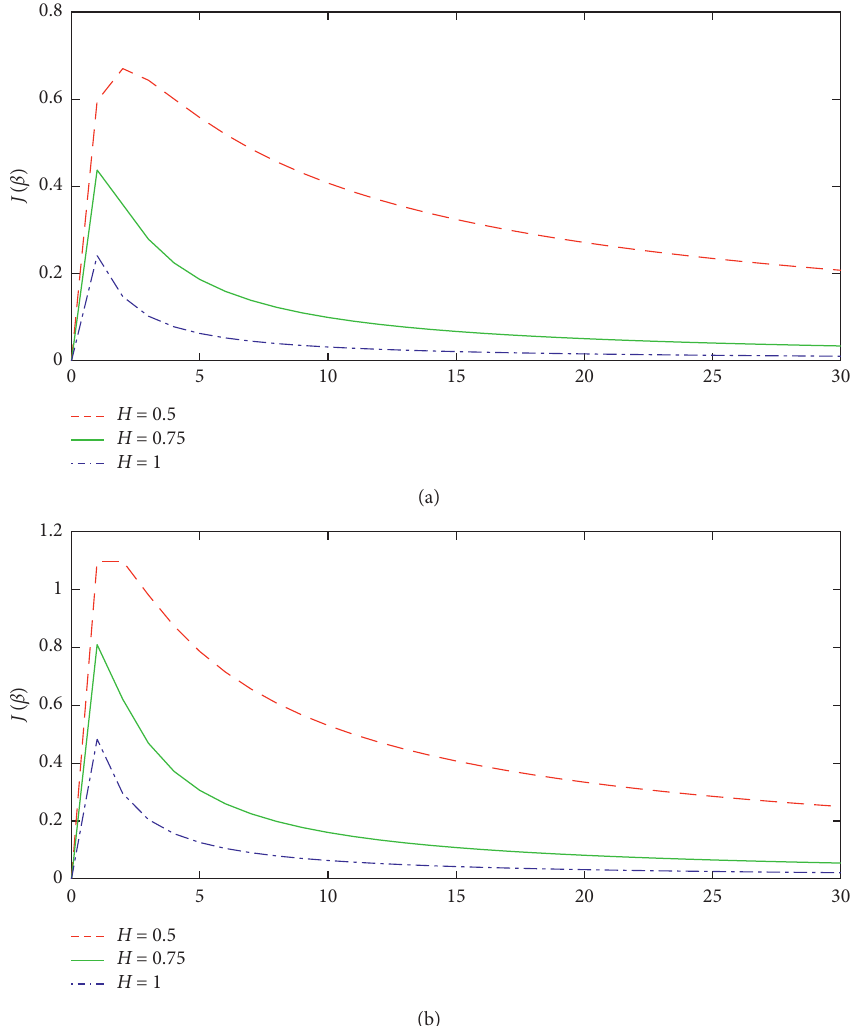
Figure 1: Hurst parameter H � 0 . 5 (top curve), Hurst parameter H � 0 . 75 (second from top), and Hurst parameter H � 1 (third from top). (a) Plot of the function J ( β ) for 3 different values of H x -axis is β . (b) Plot of the function J ( β ) for 3 different values of H x -axis is β